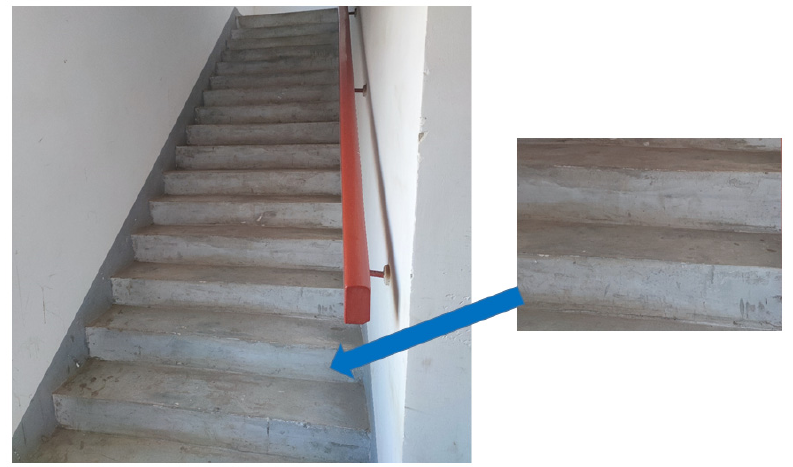
Figure 3. Height of stair steps in buildings.